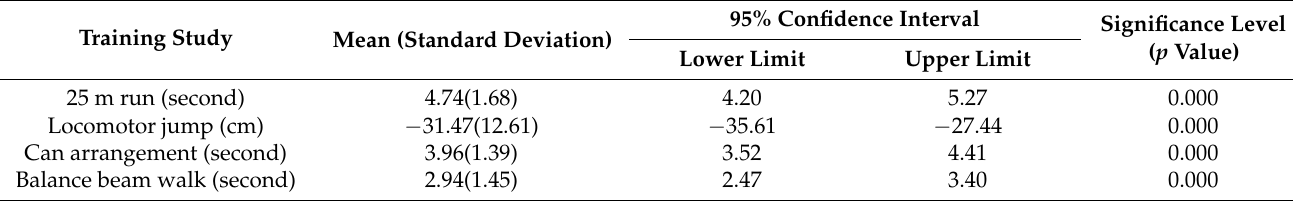
Table 4. Paired t test between pre- and post-training study of 25 m run, locomotor jump, can arrangement, and balance beam walk.